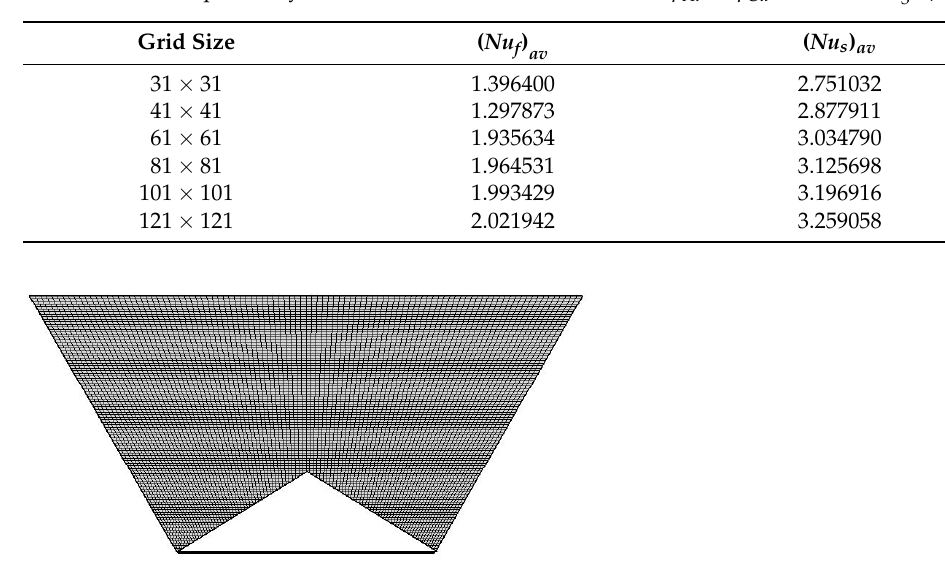
Figure 2. Mesh generation of the current geometry.